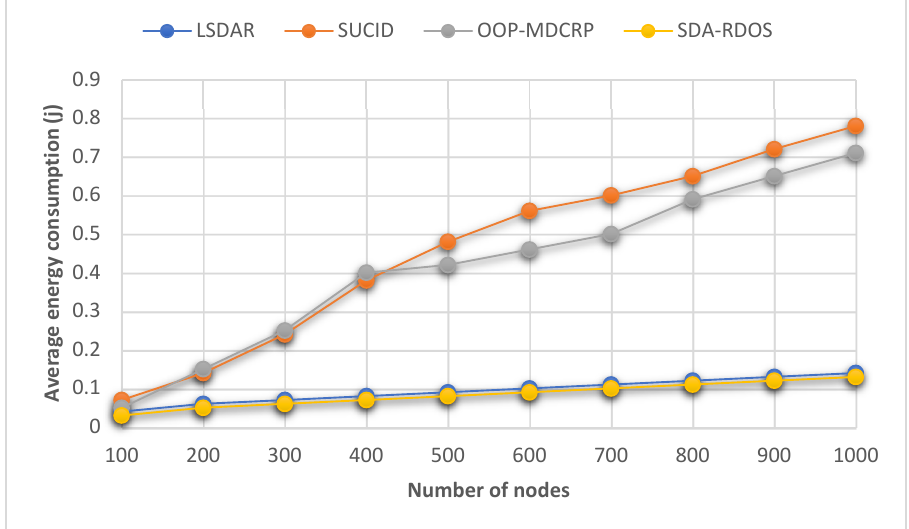
Figure 16. Energy Efficiency Analysis of LSDAR, SUCID, OOP ‐ MDCRP, and SDA ‐ RDOS protocols.